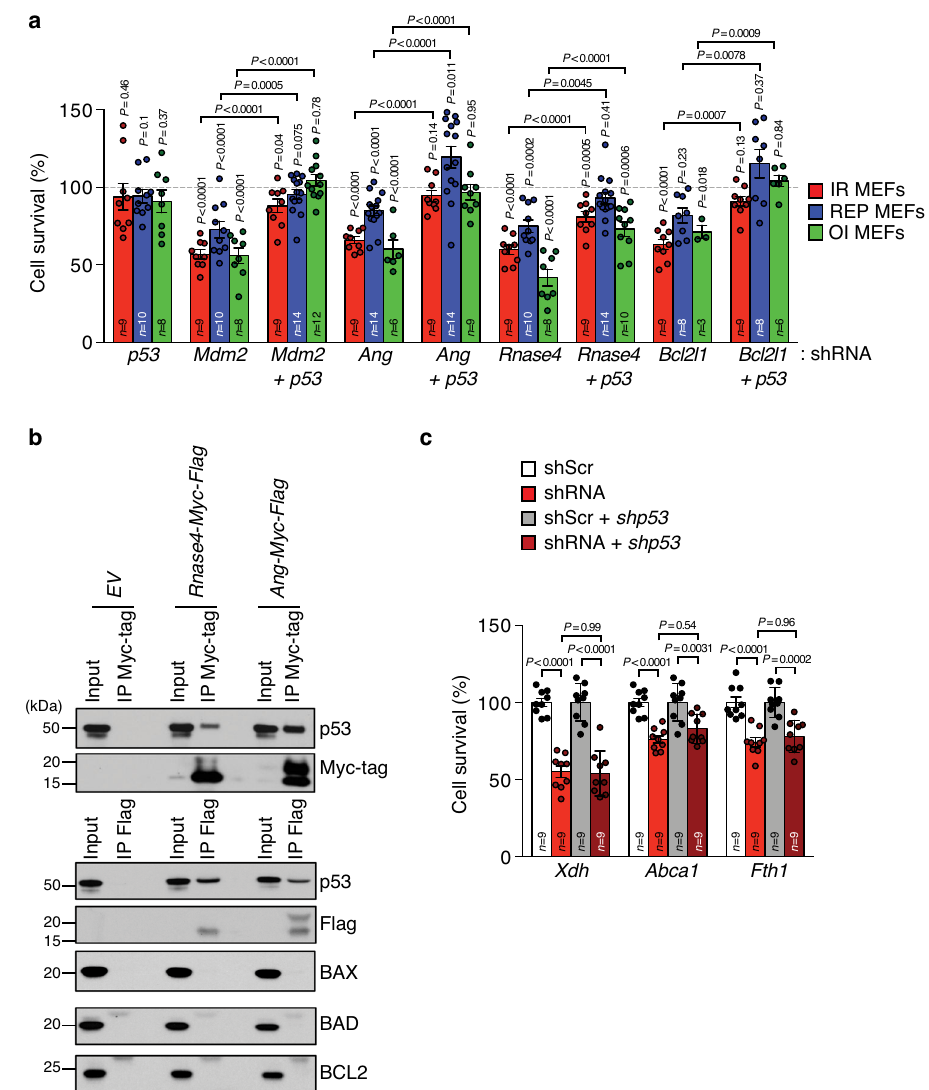
Fig. 4 Suppression of p53-dependent and -independent pathways contribute to SNC survival. a Cell survival as measured by MTS assay, of IR-, REP- and OI-SNCs at day 6 after knockdown of the indicated genes. Comparisons were with senescent MEFs containing Scr- shRNA or Scr - and p53 -shRNA (100% line). b Myc-Flag-tagged RNASE4 or ANG ectopically expressed in HEK-293T cells, precipitated with Myc- or Flag-tag-speci fi c antibodies and analyzed for co-precipitation with the indicated proteins. Western blot result is representative of 2 independent experiments. c as in a but assessing indicated SASE gene shRNA, p53 shRNA or both. We note that due to the experimental setup some shScr control values are used for several comparisons when they were assessed in the same experiment. Data represent means ± SEM. n depict independent MEF lines that were pooled from 2 to 5 independent experiments in a or 3 independent experiments in c . Statistics: one-way ANOVA with Sidak ’ s correction in a , c . Source data are provided as a Source Data fi target genes. On the other hand, RNASE4 appears to act also through p53, but independent of its transcriptional activity.